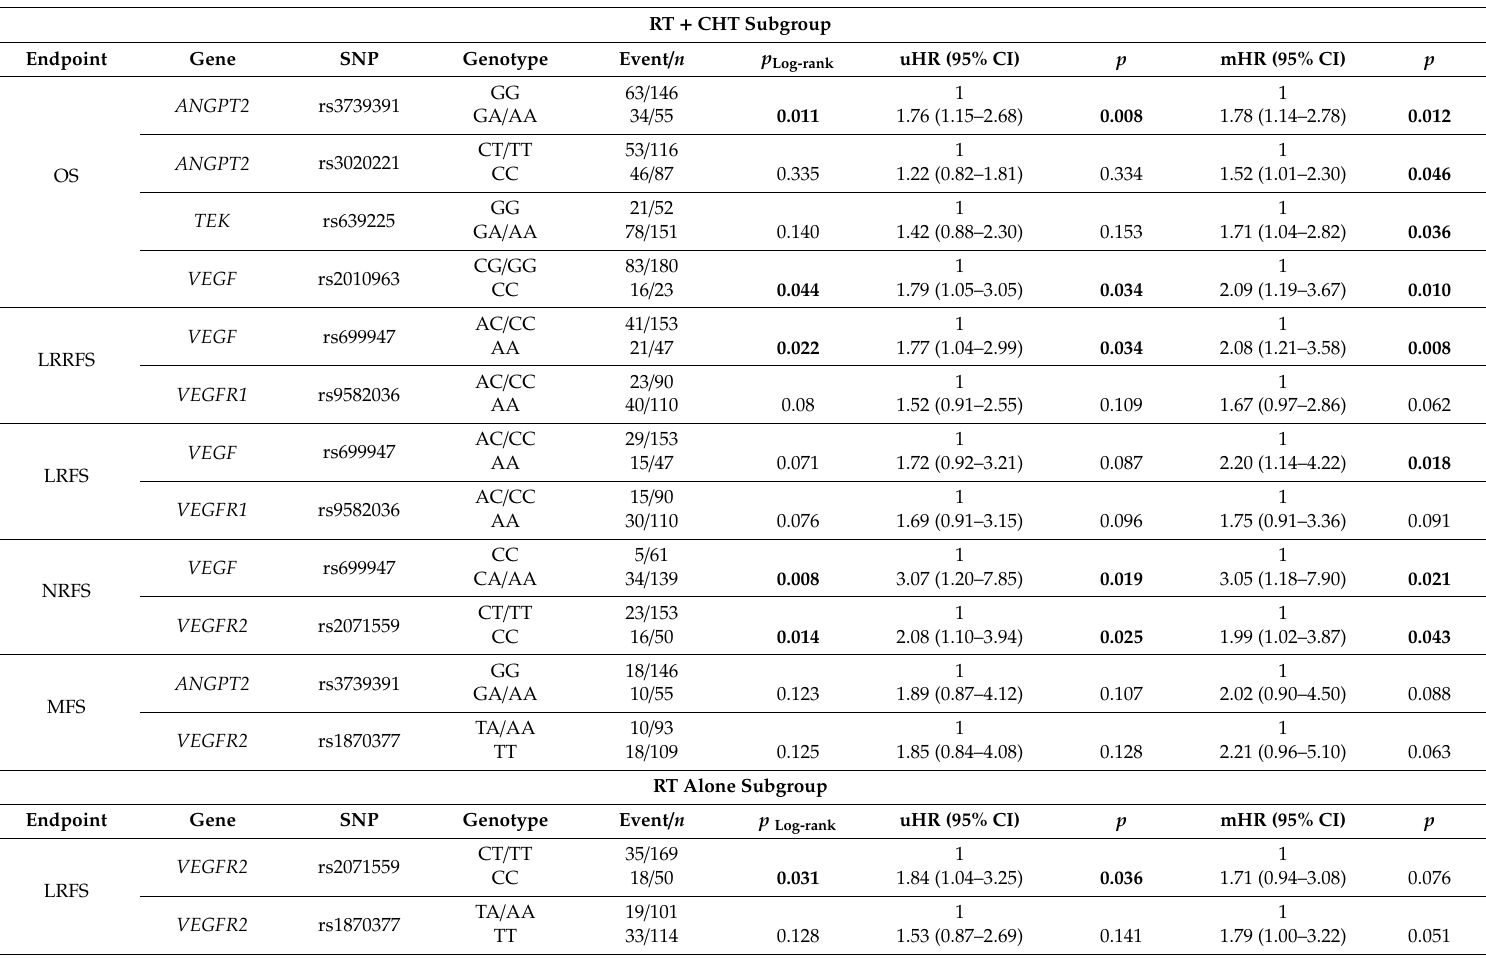
Table 3. Univariate and multivariate analysis in treatment subgroups (only SNPs with p ≤ 0.05 in univariate models or p ≤ 0.100 in multivariate models without correction for multiple testing are